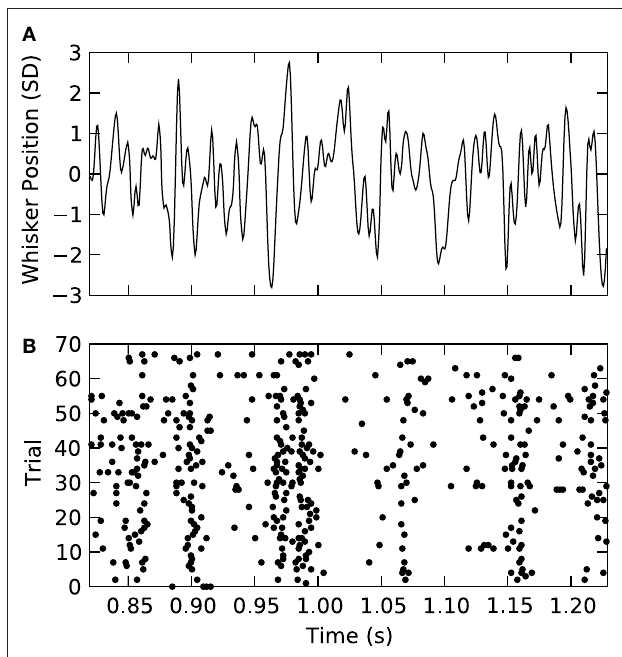
FIGURE 2 | Responses of a VPm neuron to white noise vibrissa stimulation. (A) Vibrissa position as a function of time in units of stimulus SD (1 SD = 70 µm). (B) Spikes fi red by the neuron in response to 70 repetitions of the stimulus shown in (A) .